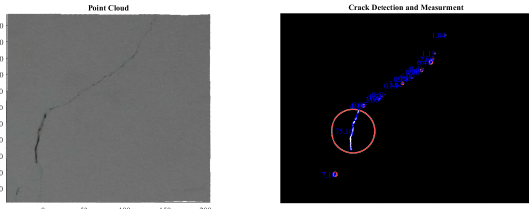
Figure 8. Comparison of registered point cloud and detection image